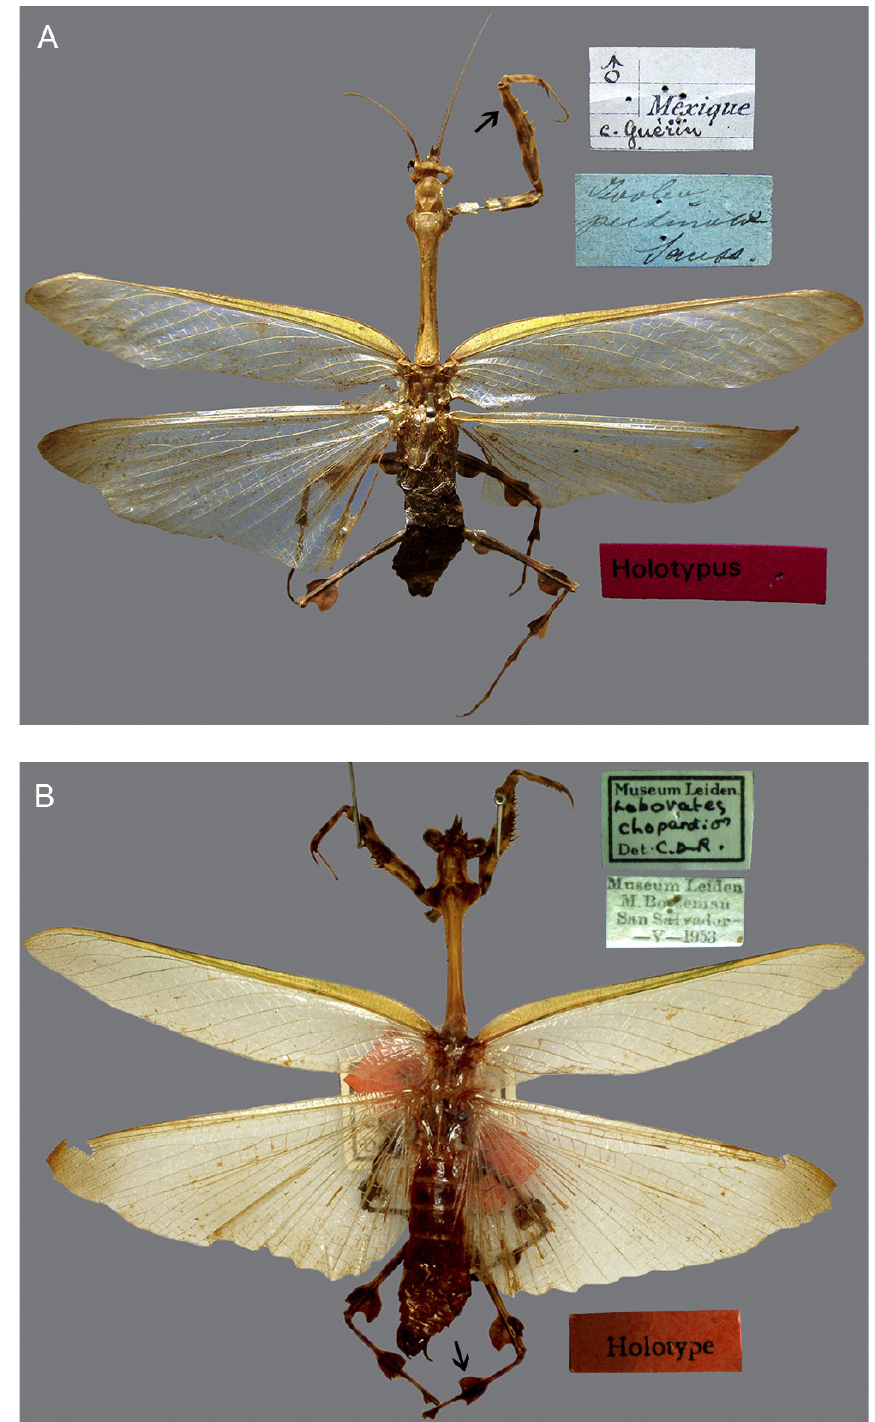
Fig. 7. A . Vates pectinata Saussure, 1871, holotype, ♂, and labels (Muséum d’histoire naturelle de la Ville de Genève, Geneva, Switzerland); note: the male and female specimens portrayed in fig. 8d–c of Svenson et al . (2016) and reported as Vates pectinata cannot be attributed to this species. B . Lobovates chopardi Deeleman-Reinhold, 1957, holotype, ♂, and labels (National Museum of Natural History, Leiden, the Netherlands); note: wings are colorless and hyaline in the actual specimen, whitish tinge is due to a photo originally taken against a white